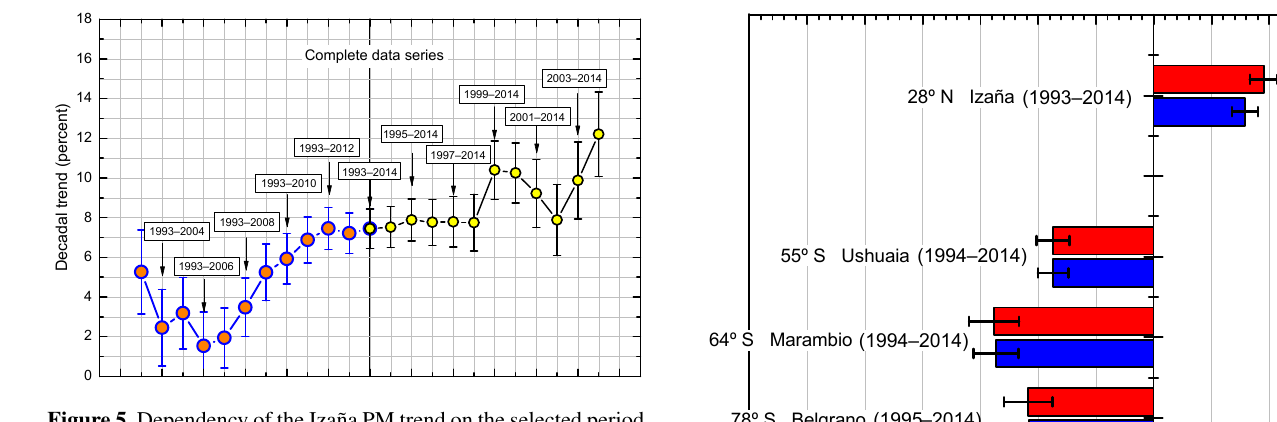
Figure 5. Dependency of the Izaña PM trend on the selected period. In the central point, the complete 1993–2014 time series is used. Each point to the left (orange circles) is the trend after reducing the time series by 1 year before 2014. Each point to the right (yellow circles) is the trend after reducing the time series by 1 year after 1993.